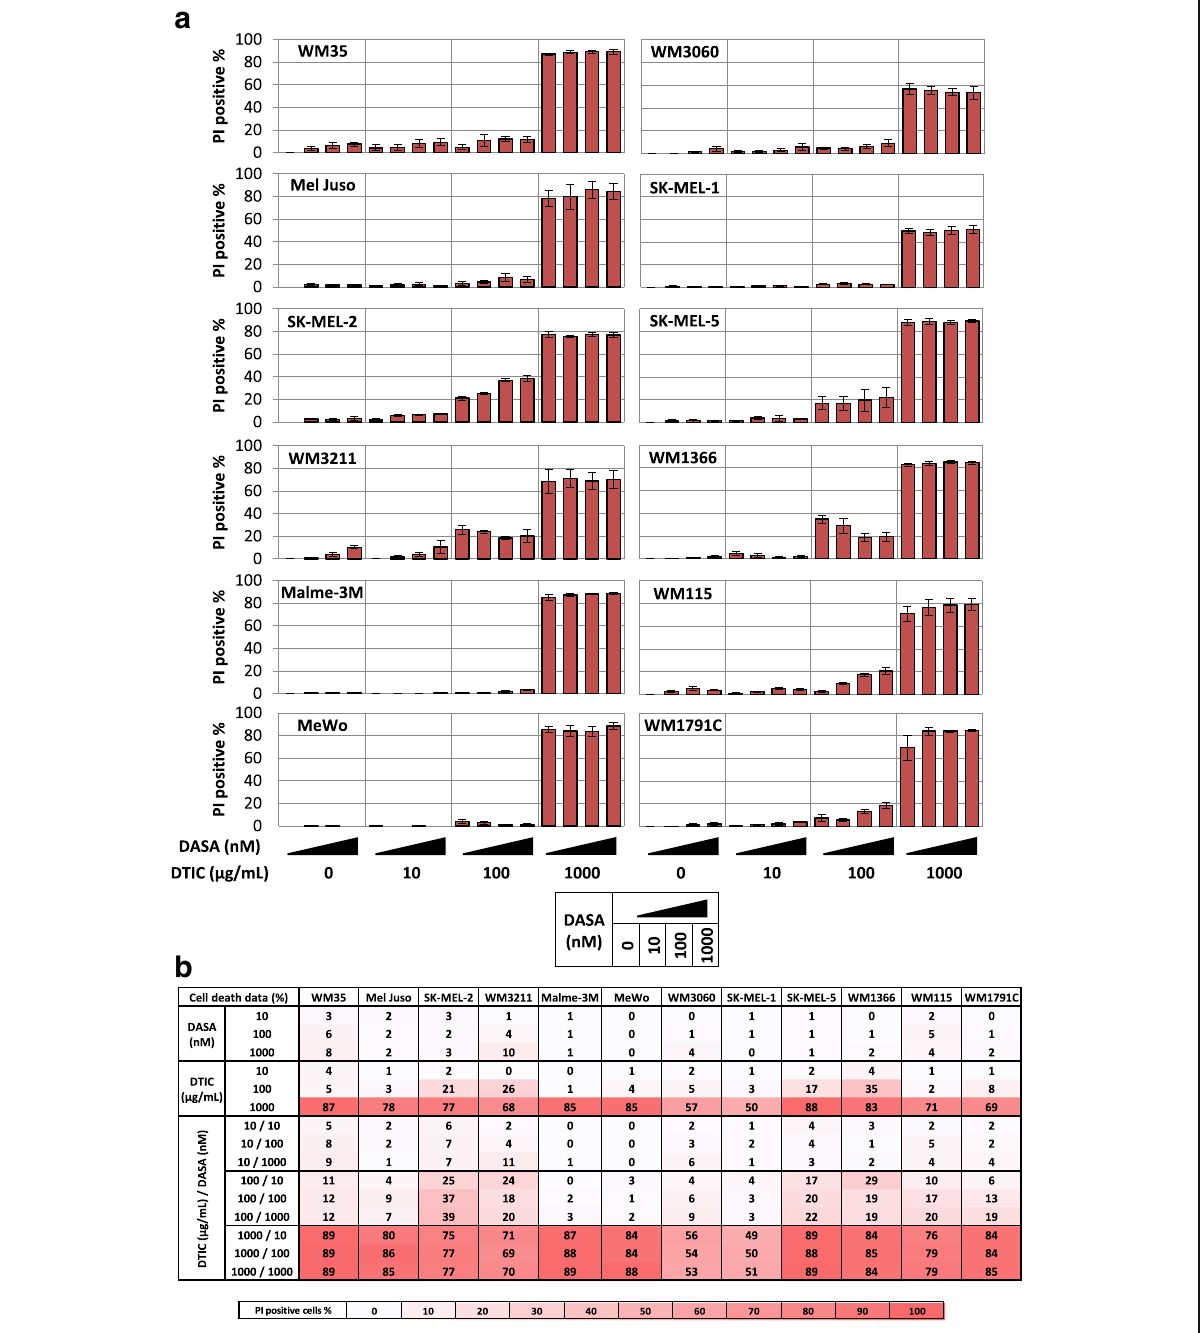
Fig. 2 Heterogeneous cell death induction in melanoma cells treated with dasatinib, alone or in combination with dacarbazine. a Cell death responsiveness (propidium iodide positivity) of melanoma cell lines after single and combination treatment with dasatinib and dacarbazine (72 h). Bars represent mean values from three independent experiments, each run with triplicate samples. Error bars show SEM. b Summary table of cell death data from ( a